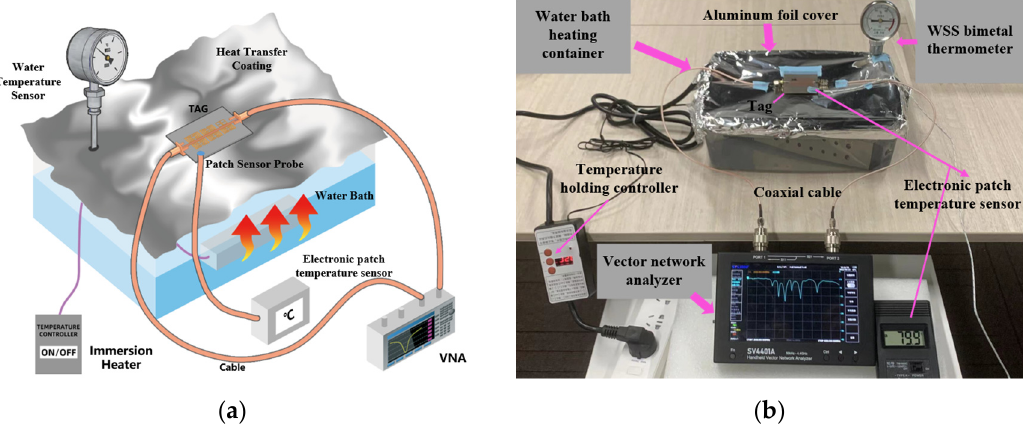
Figure 12. Tag temperature sensing characteristic test: ( a ) Tag temperature sensitivity test, 3D simulation experiment scene modeling; ( b ) Tag temperature sensitivity characteristic test in the laboratory.